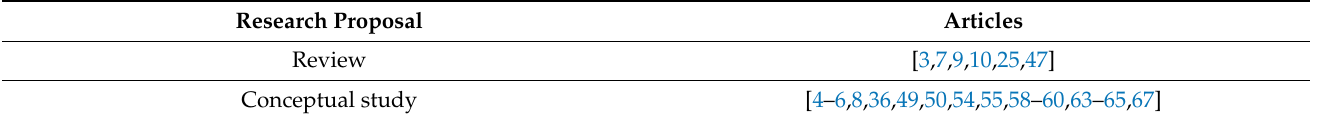
Table 1. Research proposal of the selected articles.